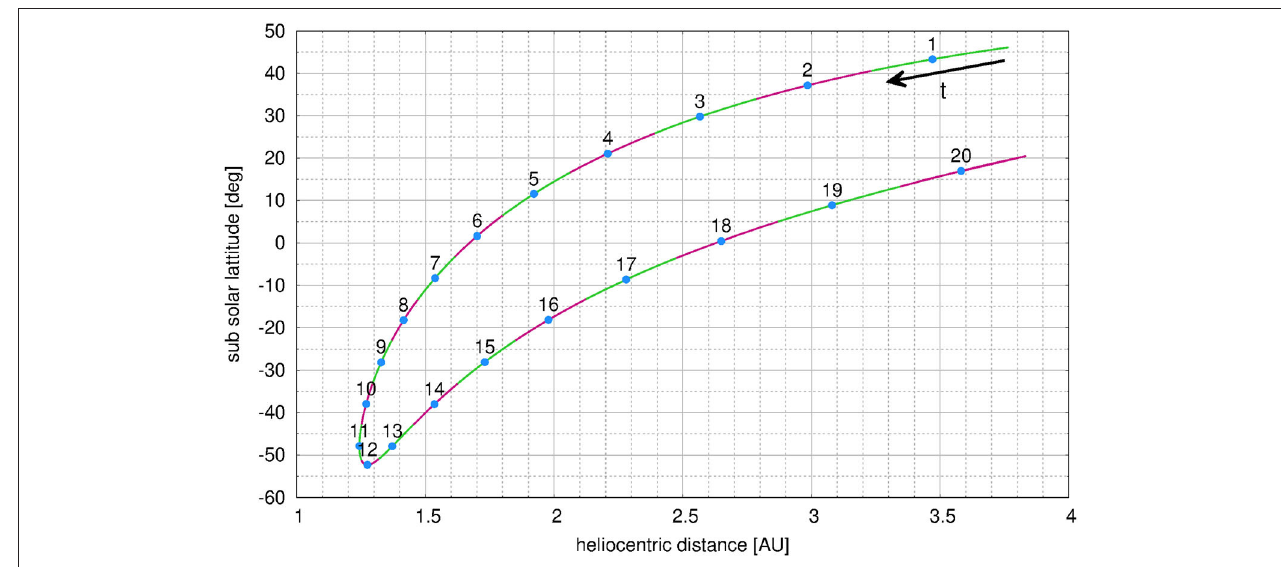
FIGURE 1 | Heliocentric distance vs. sub-solar latitude of comet 67P during the escort phase of Rosetta as well as epochs used in this work.